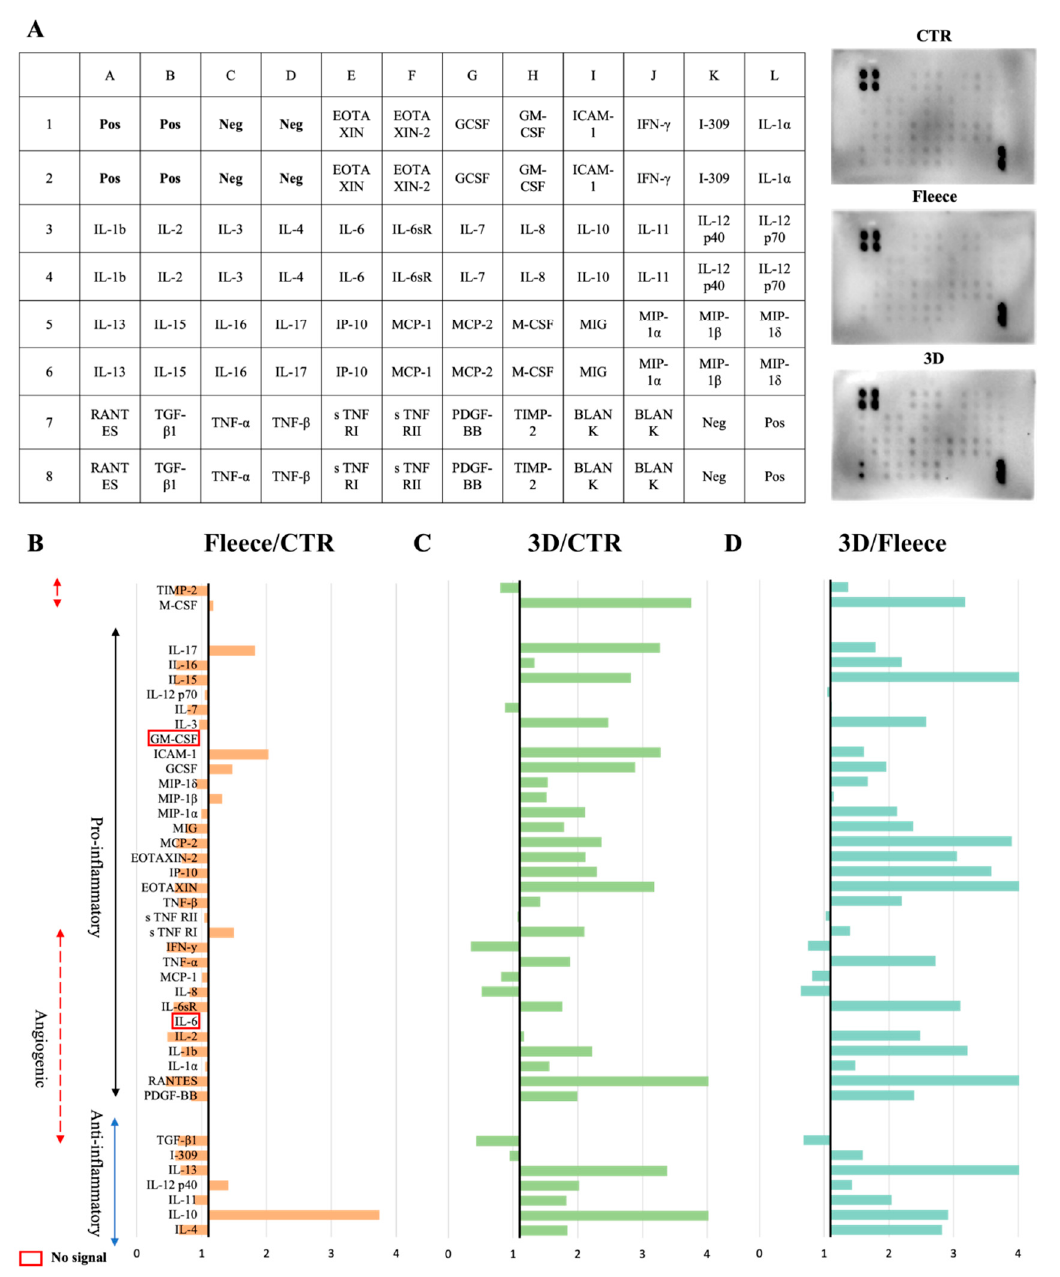
Figure 8. Immunomodulatory factors’ expression profile: anti-inflammatory factors (blue arrow), pro-inflammatory factors (black arrow) and inflammatory molecules with a role in angiogenesis (red dashed arrows). ( A ) Array’s layout and representative images of chemokines detection after 48 h of culture. ( B ) PLGA Fleeces/CTR immunomodulatory factors’ profile expression. CM of AECs seeded on Fleeces showed an almost total downregulation of factors’ release with respect to that of CTR. ( C ) PLGA 3D scaffolds/CTR immunomodulatory factors’ profile expression. CM of AECs seeded on 3D scaffolds showed an almost total enhancement in factors’ release with respect to that of CTR. ( D ) PLGA 3D scaffolds/Fleeces immunomodulatory factors’ profile expression. CM of AECs